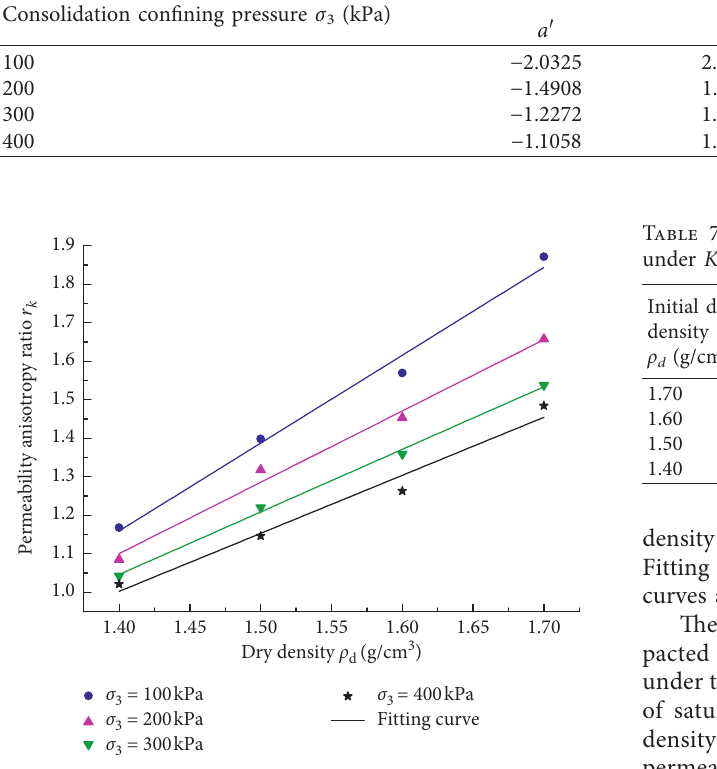
Figure 8: Relationship between the permeability anisotropy ratio and the initial dry density under confining pressure consolidation.